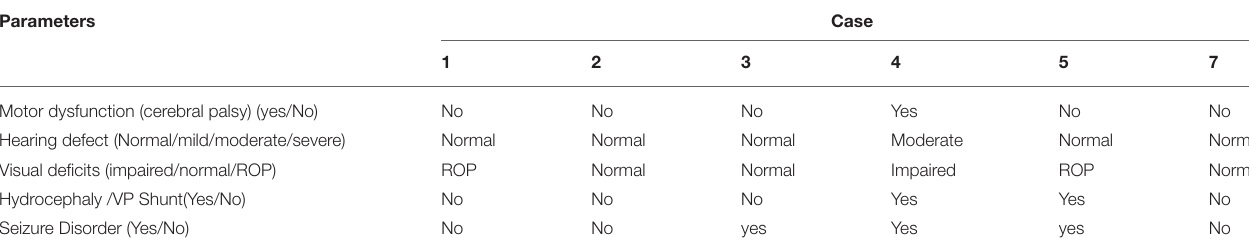
TABLE 2 | Neurodevelopment assessment of survived children with ventriculitis at 18 months of age.